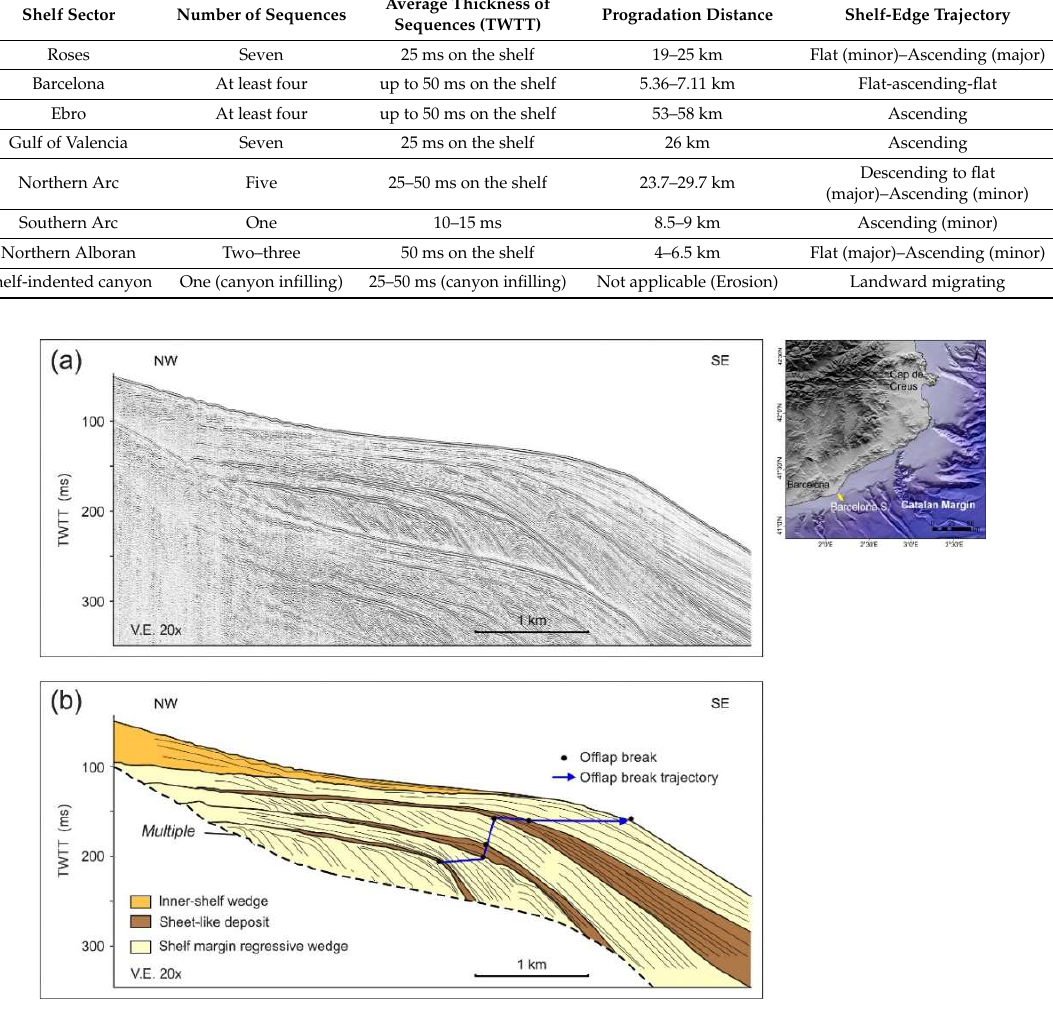
Figure 6. ( a ) Uninterpreted and ( b ) interpreted high-resolution Sparker seismic reflection profile of the Barcelona Shelf. This sector is characterized by the alternation of shelf-margin regressive wedges and sheet-like deposits. The shelf-edge trajectory is essentially flat. Modified from [7].